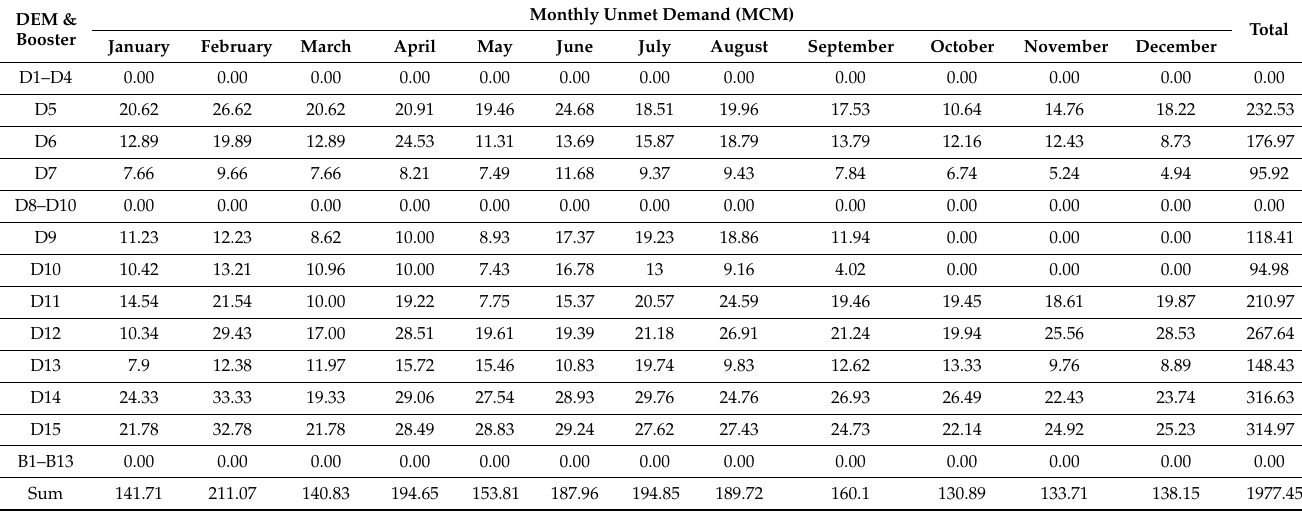
Figure 18. Monthly unmet demands (MCM) resulting from surface water only. Table 15. Monthly unmet demands (MCM) resulting from surface water from Ismailia Canal